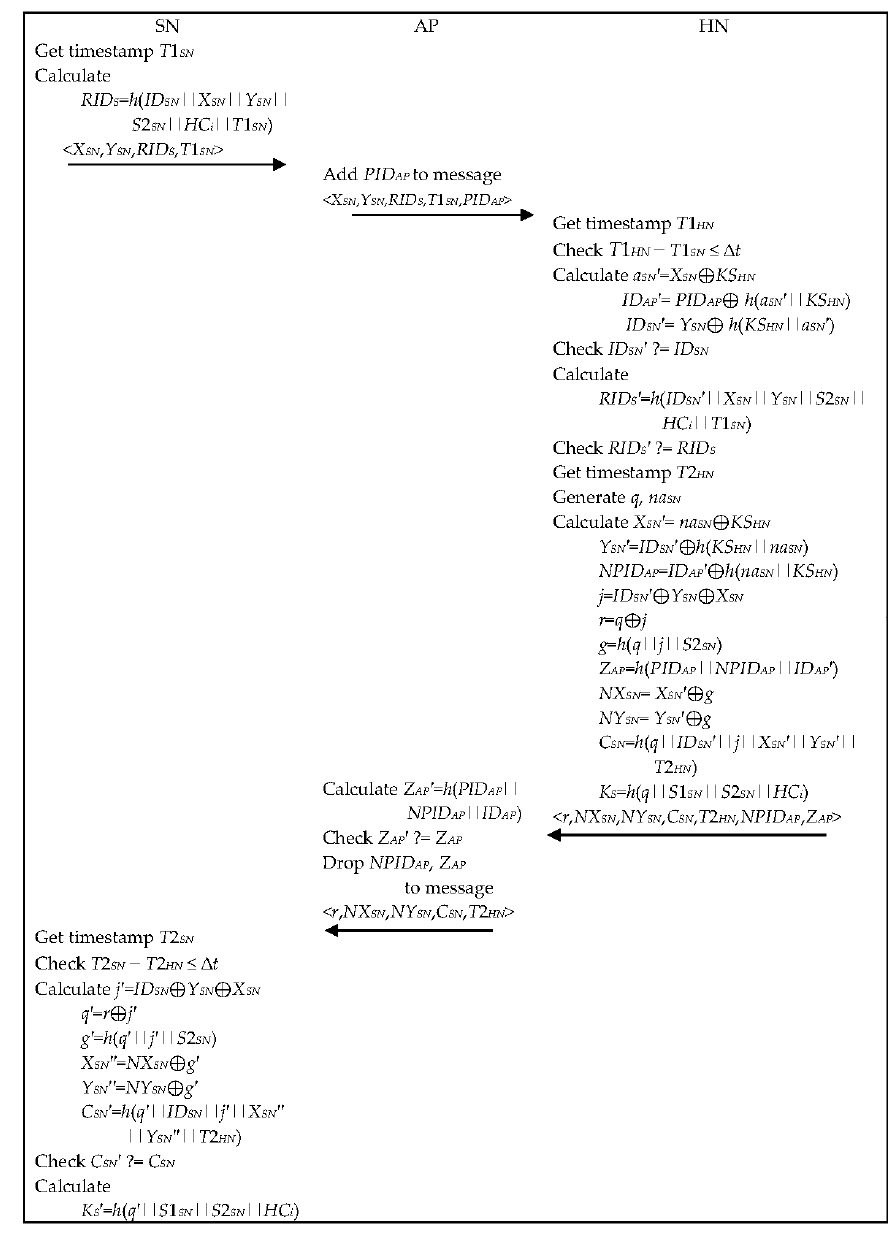
Figure 3. Authentication phase.